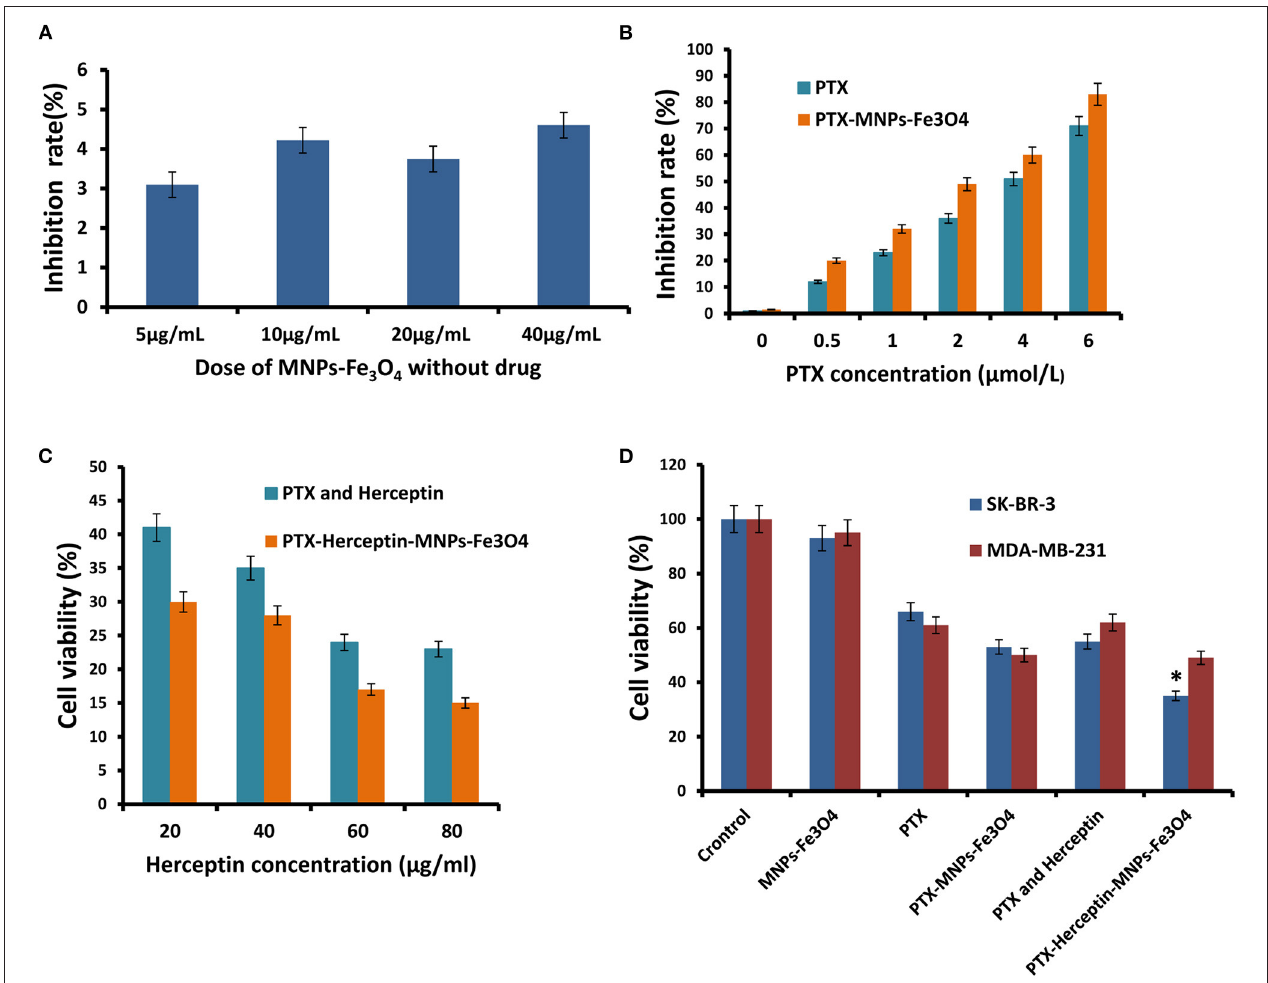
FIGURE 2 | (A) Inhibitory effects of the different concentrations of MNPs-Fe 3 O 4 on the growth of SK-BR-3 cells using the MTT assay. (B) Inhibitory effects of the combination of 20 µ g/mL MNPs-Fe 3 O 4 with different concentrations of PTX on the growth of SK-BR-3 cells. (C) Viability of SK-BR-3 cells treated with different concentrations of Herceptin. (D) Viability of SK-BR-3 and MDA-MB-231 cells treated with control, MNPs-Fe 3 O 4 , PTX, PTX-MNPs-Fe 3 O 4 , PTX-Herceptin, and PTX-Herceptin-MNPs-Fe 3 O 4 . * P < 0.05 when compared with the PTX and Herceptin